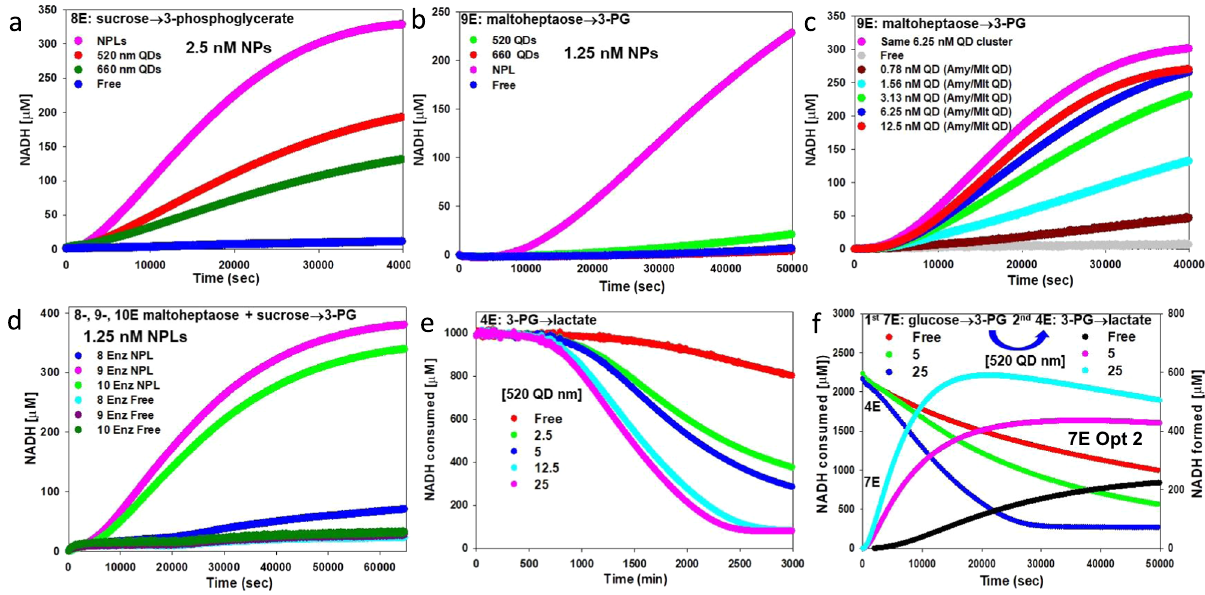
Fig. 6 | Catalytic performance in functional con fi gurations for 4, 8, 9, and 10 enzyme cascades. a 520 QD, 660 QD, and NPLs with optimized 8E cascade con- verting sucrose → 3-PG and for b optimized 9E cascade processing mal- toheptaose → 3-PG. c Varying 520 QD concentration and con fi guration with 9E cascade.Amy/Mltaddedto 7Ecascadeto yield 9E.Enzymes(Amy6.4, Malt 8.5,Glk 7.5, PGI 2, PFK 10, FBA 12, TPI 1, GPD 27, PGK 9.5nM) assembled on the same QD cluster (6.25nM pink), as a free enzyme (gray), or with increasing QD concentra- tions from 0.78 to 12.5nM where Amy/Mlteach assembled separately to their own QD cluster at 1/7th total QD concentration and added to the 7E cluster. d 1.25nM NPLsassembledwith8Ecascade(7E+Inv),9Ecascade(7E+Amy/Mlt),10Ecascade (7E+Inv/Amy/Mlt), and free enzyme controls assayed with 120mM sucrose and 4mM maltoheptaose substrate. Ratios of enzyme/NPL in Supplementary Table 2. e Progress curves measuring NADH consumption for clusters with increasing 520 QDs added to fi xed concentration 4E cascade converting 3-PG → lactate (PGM 18,